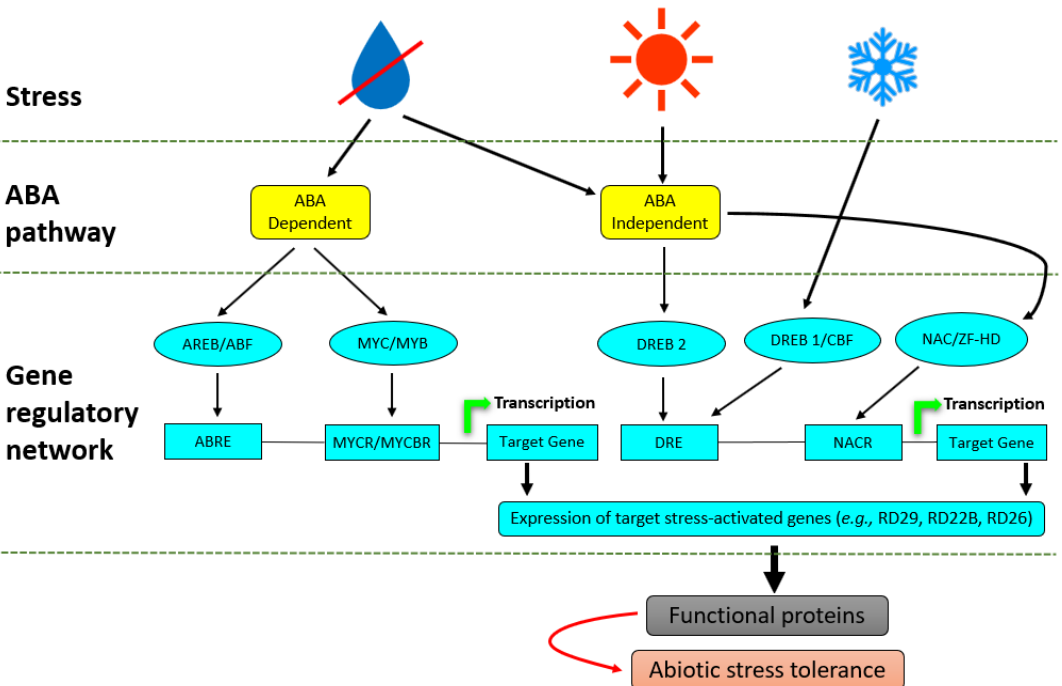
Figure 2. Transcriptional regulatory networks of abiotic stress signals. Signal transduction pathways in drought, heat and cold-stress responses are either ABA-dependent or ABA independent. In the ABA-dependent pathway, ABRE functions as a main ABA-responsive element. MYB2 and MYC2 function in ABA-inducible gene expression of the RD22 gene. MYC2 also functions in JA-inducible gene expression. The RD26 NAC transcription factor is involved in ABA and JA-responsive gene expression in stress responses. DRE is mainly involved in the regulation of genes not only by drought and salt but also by cold stress. DREB1/CBFs are involved in cold-responsive gene expression. DREB2s are important transcription factors in dehydration and high salinity stress-responsive gene expression. Another ABA-independent pathway is controlled by drought and salt, but not by cold.